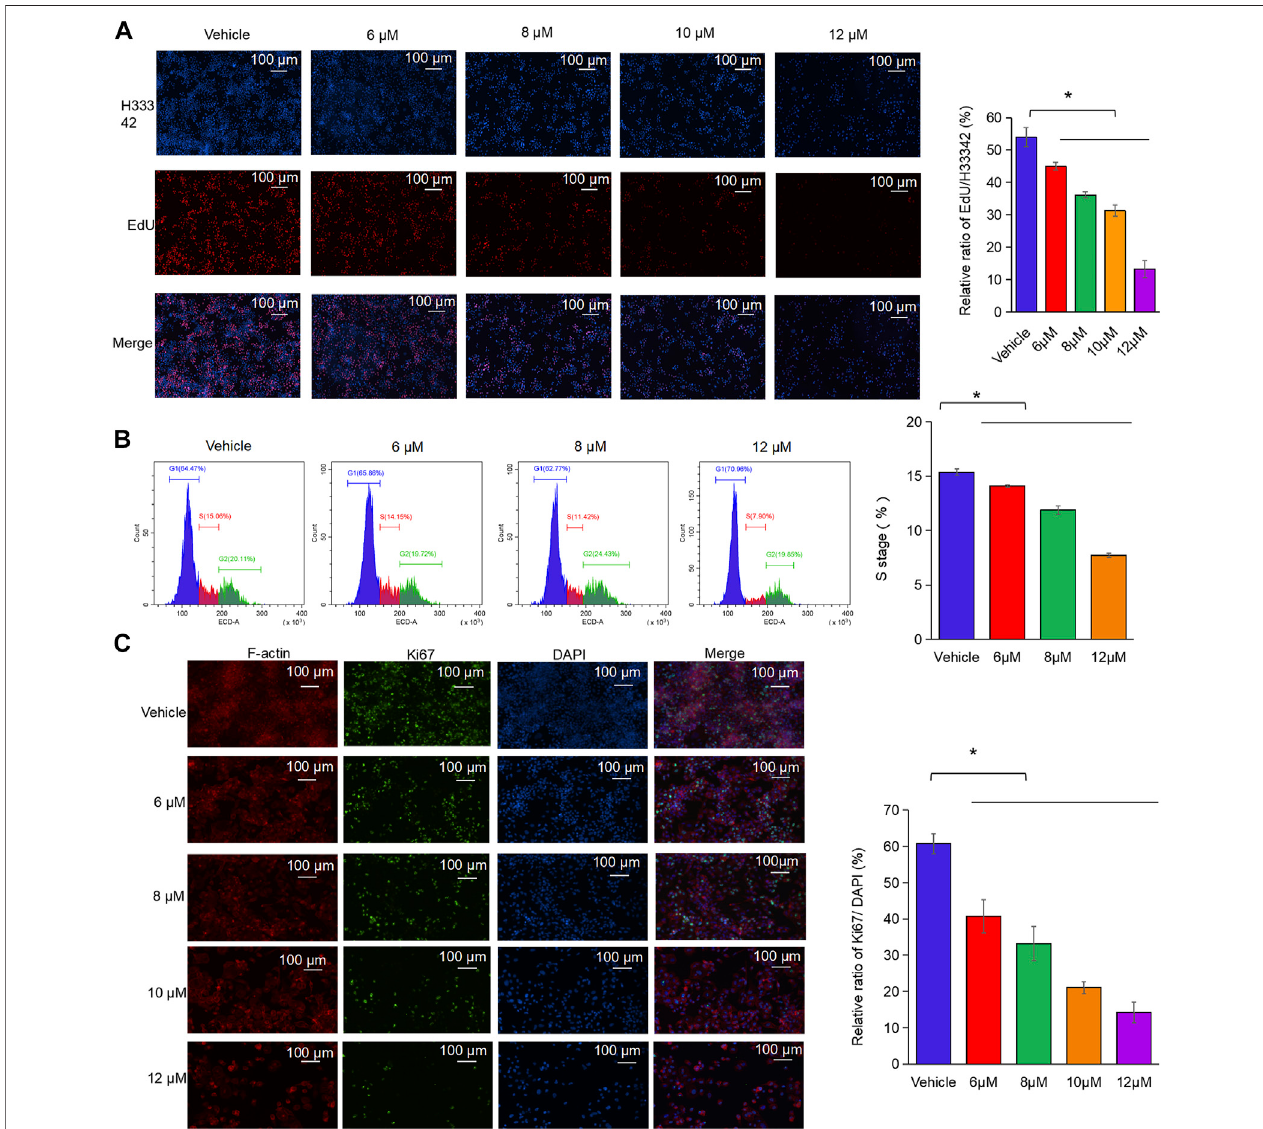
FIGURE 3 | Nodosin repressed the proliferation of CRC cells by inhibiting DNA synthesis. (A) Nodosin-treated SW480 cells were stained with EdU and Hoechst 33342, and then cell proliferation was observed with fl uorescence inverted microscope (EdU stained cells in red, Hoechst 33342 stained cells in blue). (B) Nodosin- treated SW480 cells were stained with PI. The cell cycle of staining cells was detected by fl ow cytometry. The blue area was G1 phase cells, the red area was S phase cells, and the green area was G2 phase cells. The signi fi cant difference was evaluated with one-way ANOVA analysis followed by LSD Post Hocmultiple comparison,and p -value < 0.05wasconsideredsigni fi cant. (C) SW480cellsweretreatedwithdifferentconcentrationsofnodosinfor24 h.TheKi67wasdetectedbyIF. F-actin was red fl uoreacence, Ki67 was green fl uorescence, and DAPI was blue fl uorescence. The signi fi cance difference was evaluated with one-way ANOVA analysis followed by LSD Post Hocmultiple comparison, and p -value < 0.05 was considered signi fi cant.